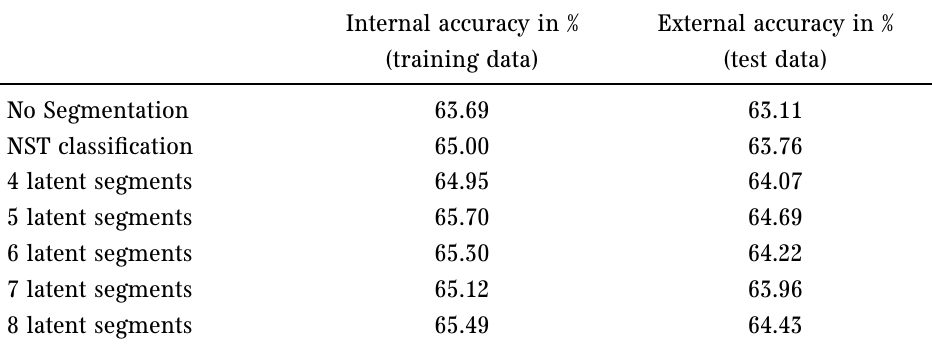
Table 9: Overall accuracy of shipment size choice